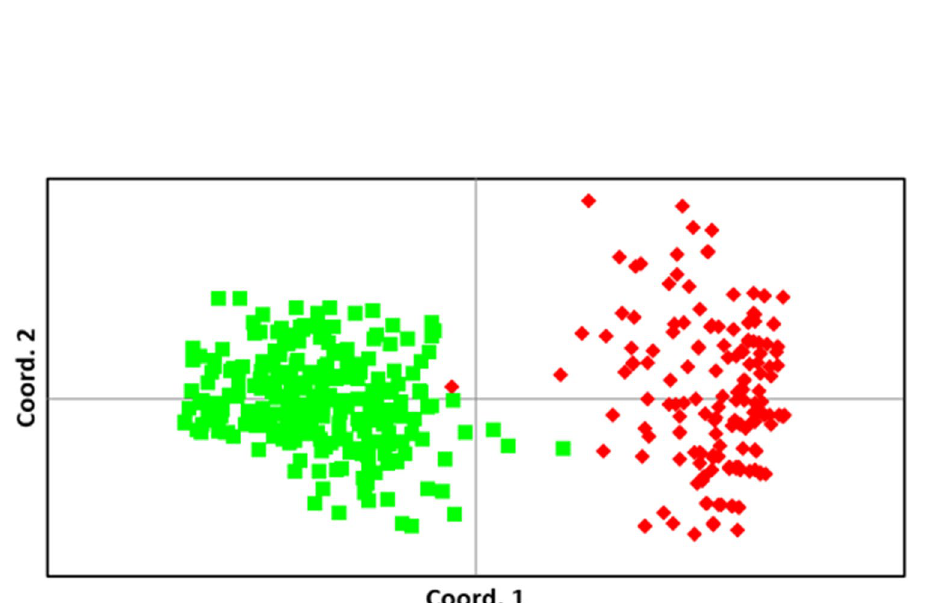
Figure 2. Principal coordinates analysis (PCoA) using genetic distance matrices. Individuals from the K’gari (red) and Mainland (green) populations are indicated. Coordinate axes 1 and 2 account for 24.75% and 5.30% of the variation in the